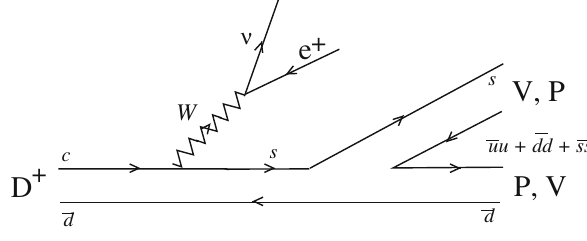
Fig. 1 Elementary D + → ν e + V P process at the quark